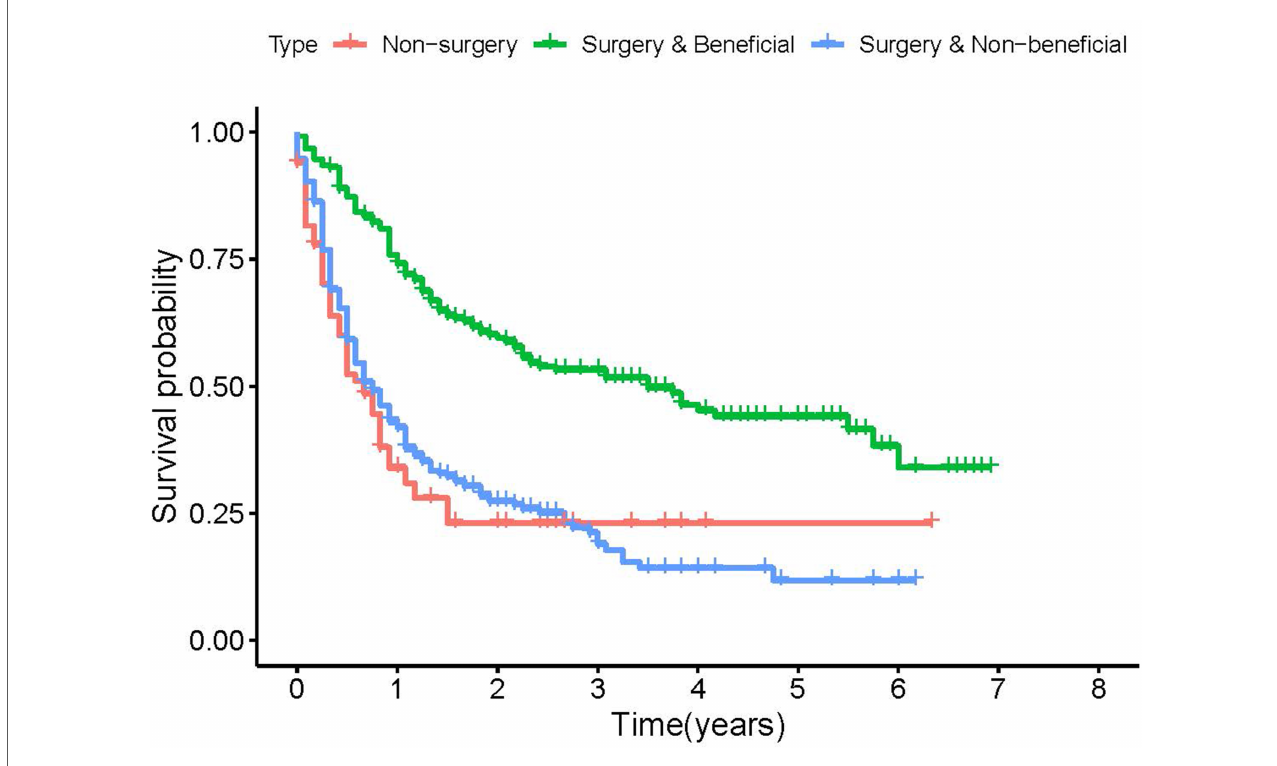
FIGURE 6 Kaplan-Meier plot to differentiate bene fi cial groups according to our